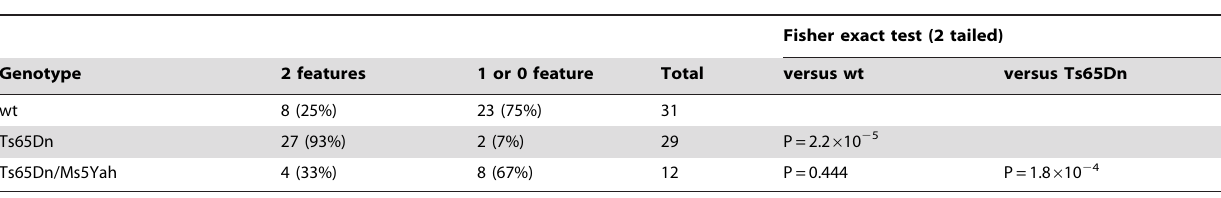
Table 2. Comparison of ECG anomalies in the different mouse